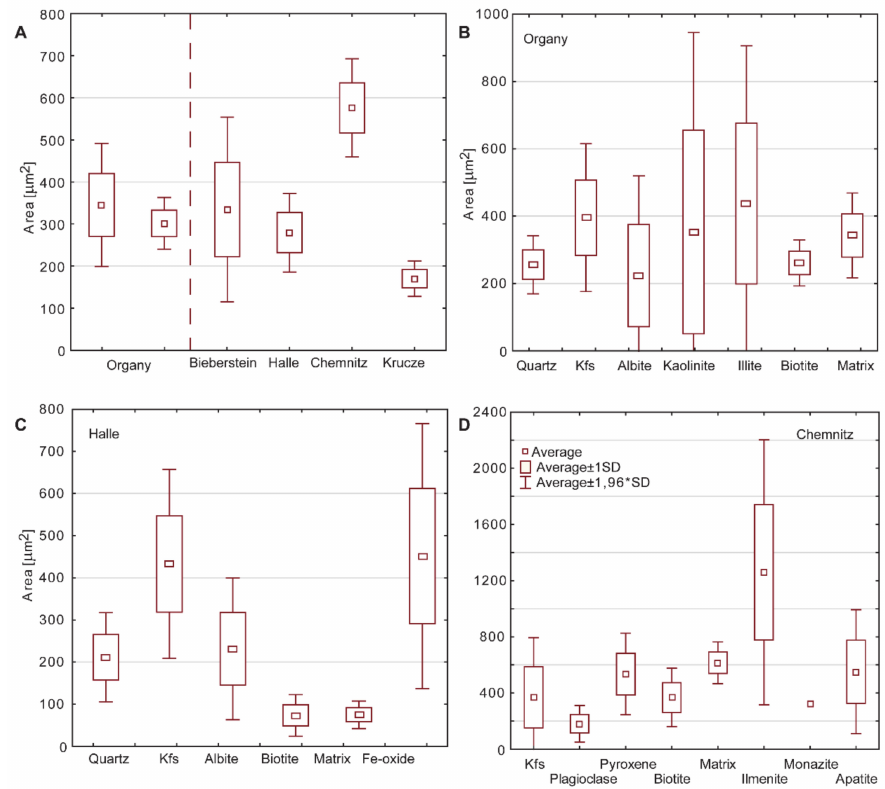
Figure 7. Statistical comparison of zircon sizes ( µ m 2 ) between localities ( A ) and between zircon associated with di ff erent minerals for each locality ( B – D ): (A) significant variations ( p < 0.05) are observed for Krucze and Halle; ( B ) data do not show significant variations between populations; ( C ) zircon associated with KFs and Fe-oxide is significantly larger than zircon associated with the matrix; ( D ) data do not show significant variations between populations; however, the largest zircons are clearly associated with ilmenite. Input data from MLA, shown in Supplementary Materials. Plots